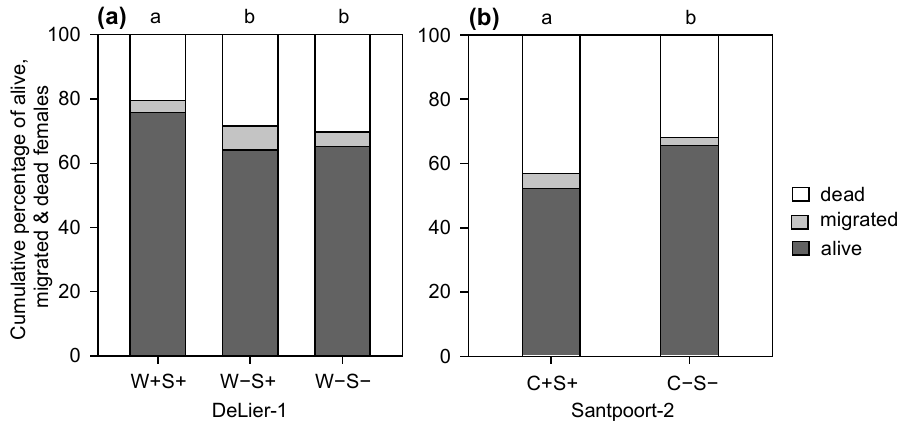
Figure 1. Survival, migration and mortality in two strains of the spider mite T. urticae which did (+) or did not ( − ) contain Wolbachia (W), Spiroplasma (S) and/or Cardinium (C); ( a ) The DeLier-1 strain with three groups: W+S+, W − S+ and W − S − ; ( b ) The Santpoort-2 strain with two groups: C+S+ and C − S − . Different letters above the bars indicate significant differences at a level of p ≤ 0.05, after applying generalized linear mixed models followed by Tukey multiple comparisons with Holm adjustment. Note that experiments with the Santpoort-2 strain could not be performed with all four lines and that results obtained with the remaining lines were inconsistent, see Figure S2.